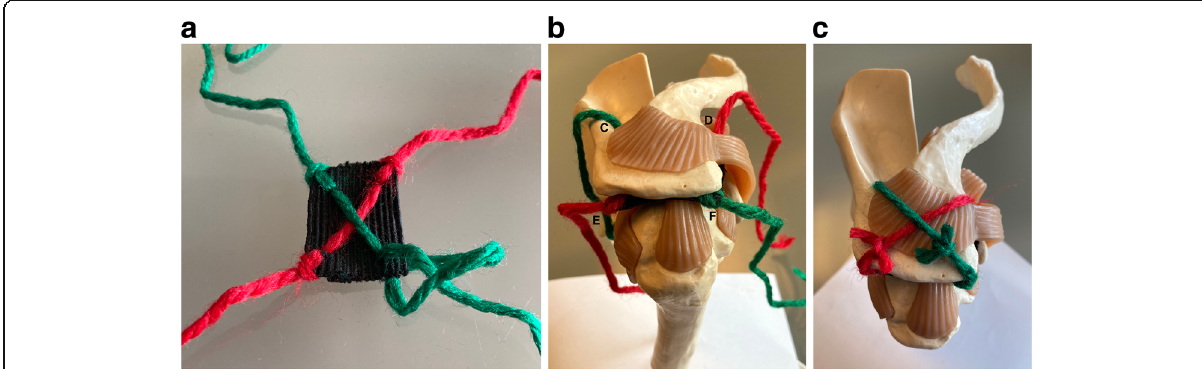
Fig. 5 Schematic display of the construct in a model. a Crossed suture tape configuration with “ lasso-loop ” knots at each corner of the graft. b Graft in a subacromial position and suture limbs exteriorized through their respective skin incisions. c Finalized graft positioning after tying over the